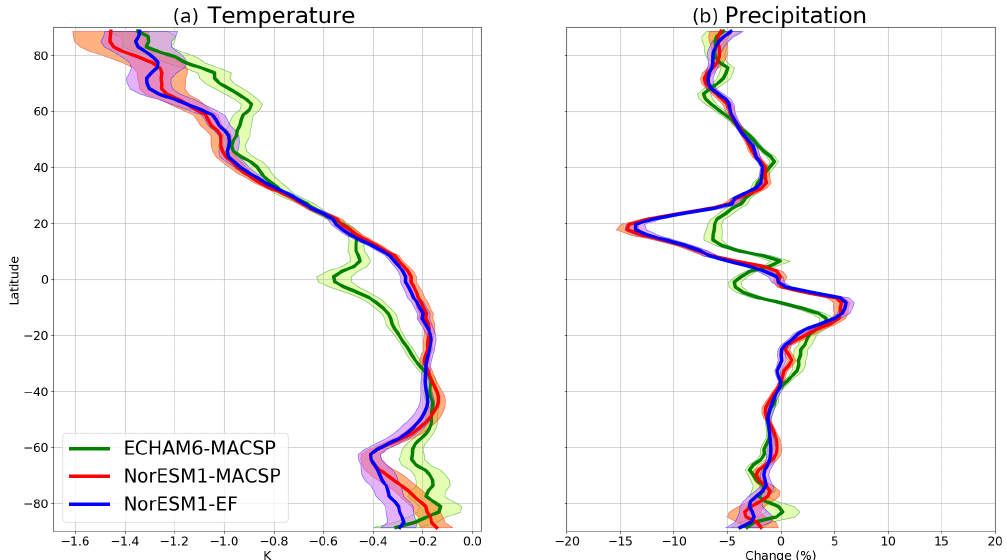
Figure 3. Impact of MACSP anthropogenic aerosols on zonal-mean temperature (K) and precipitation (%) in ECHAM6-MACSP, NorESM1- MACSP and NorESM1-EF experiments. The shaded area shows the standard error of the mean as a function of